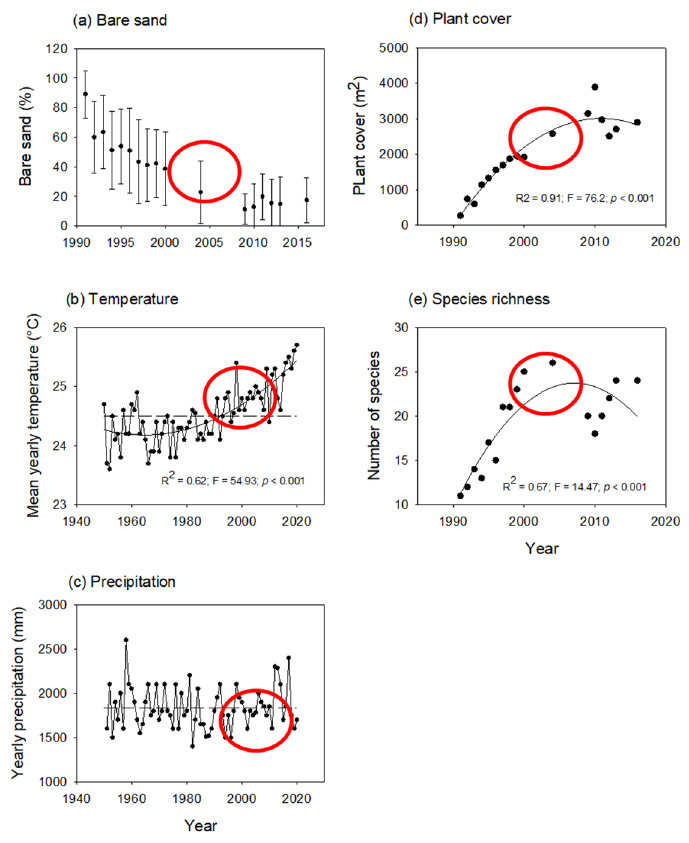
Figure 1. Temporal variability of environmental variables ( a ) mean bare sand per plot (1991–2016), ( b ) total yearly precipitation, ( c ) mean annual temperature (1950–2020) from the on-site weather station, and ( d ) total plant cover and ( e ) total species richness (1991–2016) at the study site. Significant correlations are shown with their corresponding regression values. Horizontal fragmented lines show mean values over the period shown. Red circles show consecutive years that were both warmer and drier and that affected vegetation